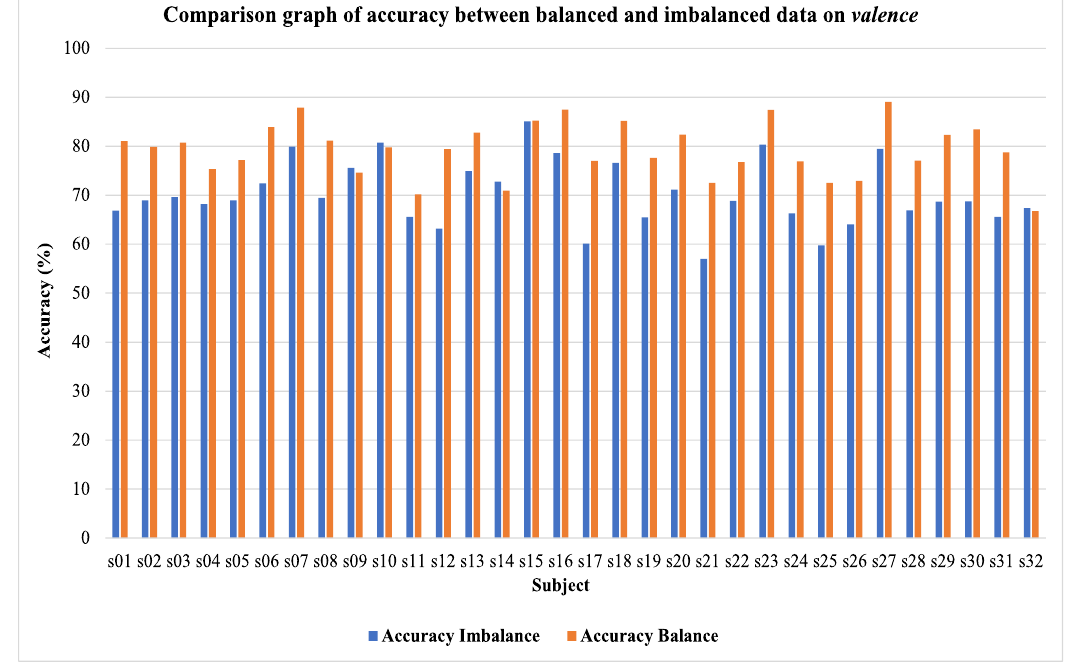
Figure 11. Comparison of valence accuracy for using CNN and with or without the Radius SMOTE method